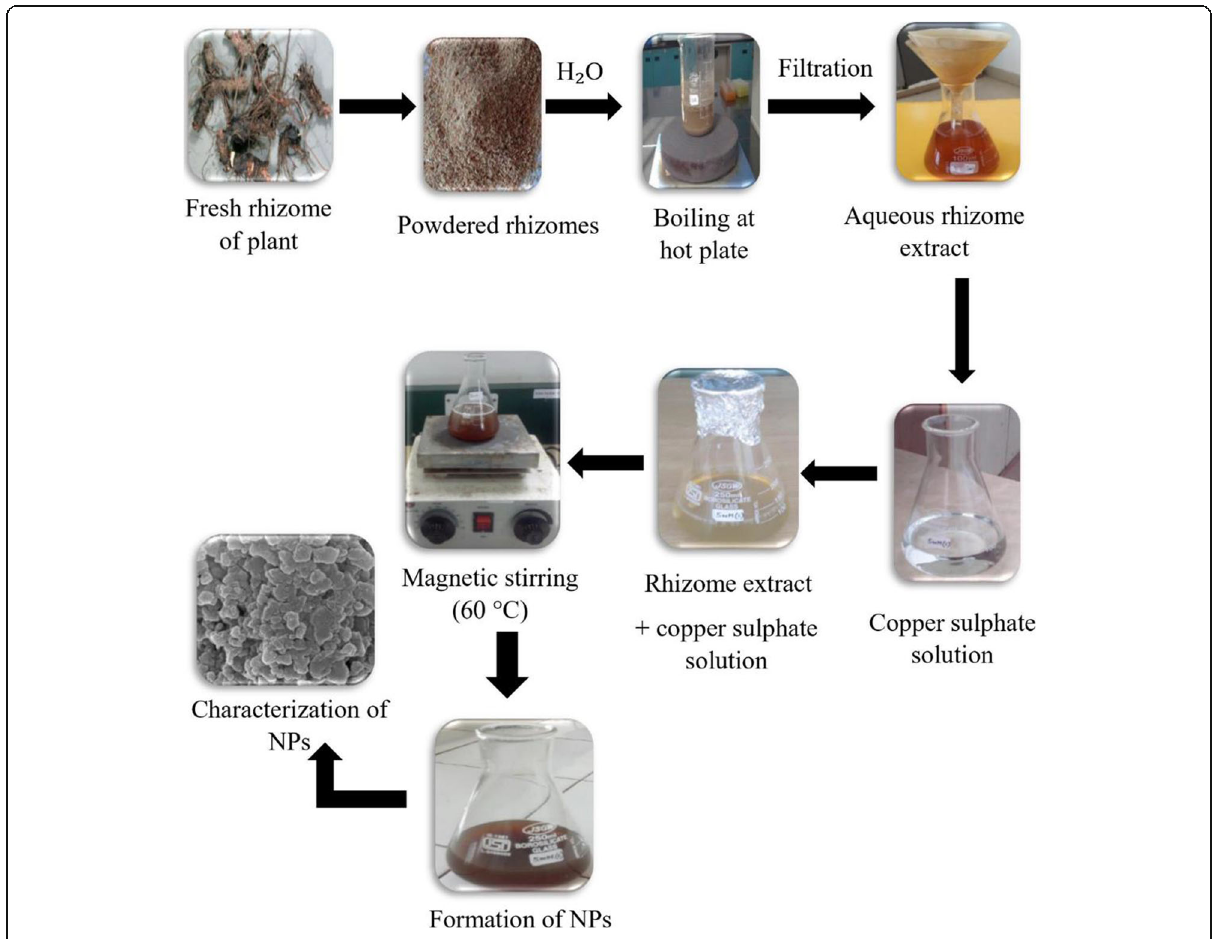
Fig. 1 Schematic of plant-mediated CuO NPs